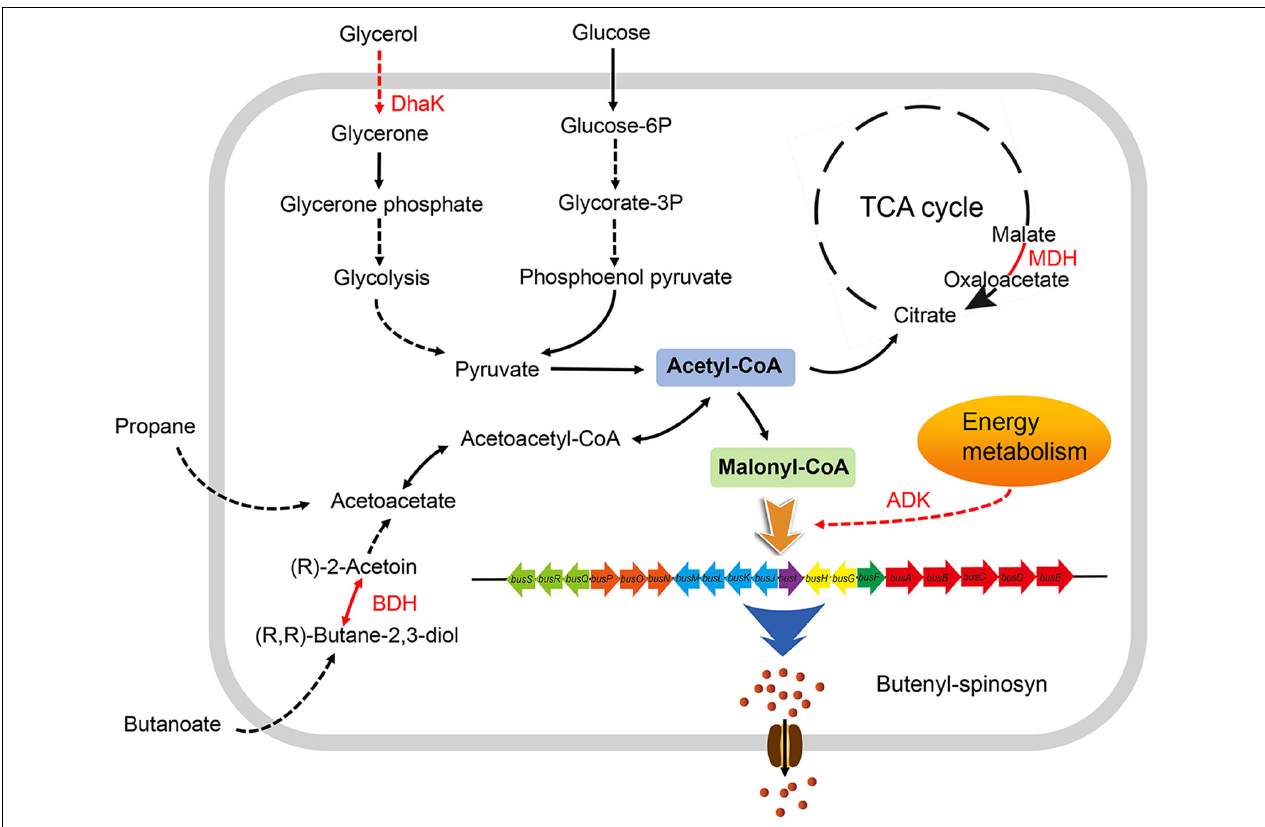
FIGURE 6 | Effects of PhoU on the metabolic network in Saccharopolyspora pogona . The enhanced expression of DHAK and BDH in S. pogona - phoU promotes the degradation of glycerol and butanoate, which favors the synthesis of acetyl-CoA, thereby promoting the TCA cycle and the synthesis of the precursor malonyl-CoA. Enhanced expression of MDH and ADK further promotes the progression of the TCA cycle and the energy supply for butenyl-spinosyn biosynthesis. Therefore, PhoU indirectly affects glycerol and butanoate metabolism, TCA cycle, and energy metabolism via regulating intracellular phosphate levels, providing more malonyl-CoA precursors and energy for butenyl-spinosyn biosynthesis. Differentially expressed proteins in S. pogona - phoU are shown in red font; black arrows indicate that the process is not affected; red arrows indicate that the process is enhanced; solid arrows indicate that the process has only one-step reaction; dashed arrows indicate that multiple-step reactions are omitted in the